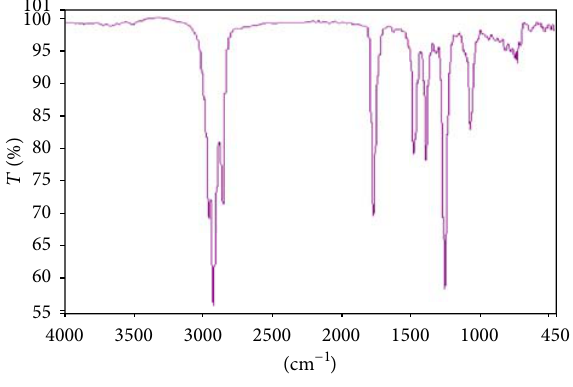
Figure 8: Raw FTIR spectrum of regular diesel.